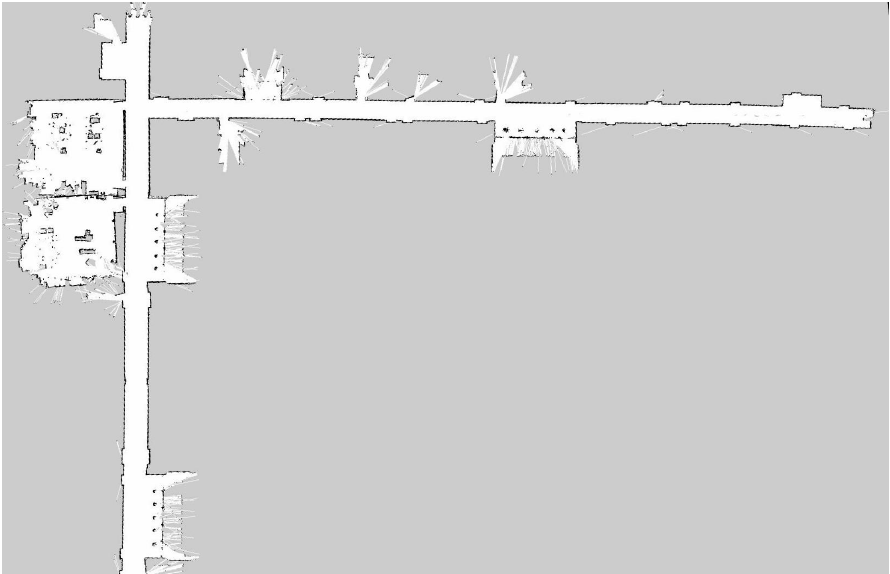
Figure 7. Partial SLAM map for floor